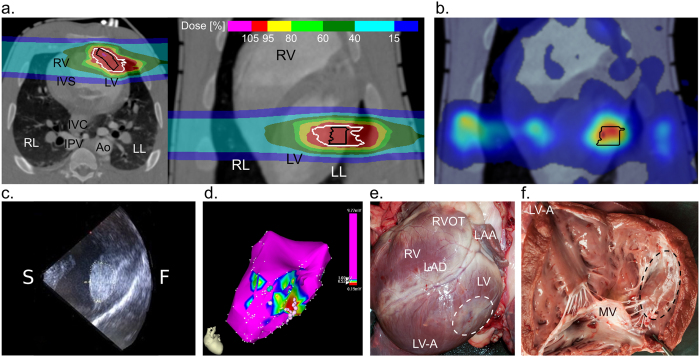
Outcomes after Left Ventricular (LV) Freewall Irradiation.(a) Transverse and coronal plane of a treatment plan with two lateral carbon beams (40 Gy). Details as described for Fig. 1a. (b) Anteroposterior view of by-product β+-activity during irradiation via PET, superimposed on the coronal plane of a contrast-enhanced CT scan. Black contour = target contour, β+-activity shown as color-wash. (c) Intracardiac ultrasound image of the LV freewall after irradiation, hyperechoic lesion area marked by dotted lines. (d) Left anterior oblique view of an endocardial voltage map of the LV 6 months after irradiation. As indicated in the legend, local voltage >1.0 mV is depicted in magenta. Voltage <0.5 mV in red. Other colors mark voltages in-between. White dots = fragmented potentials. (e) Macroscopic LV epicardial lesion outcome six months after irradiation with the dashed line marking the contoured target zone. (f) Endocardial lesion outcome six months after irradiation. Ao = Descending aorta; F = Freewall; LAA = Left atrial appendage; LAD = Left anterior descending coronary artery; LIPV = Left inferior pulmonary vein; LVOT = Left ventricular outflow tract behind the mitral valve leaflet; LL = Left lung; IVC = Inferior vena cava; LV = Left ventricle; LV-A = Left ventricular apex; RIPV = Right inferior pulmonary vein; RL = Right lung; RV = Right ventricle; S = Septal site.